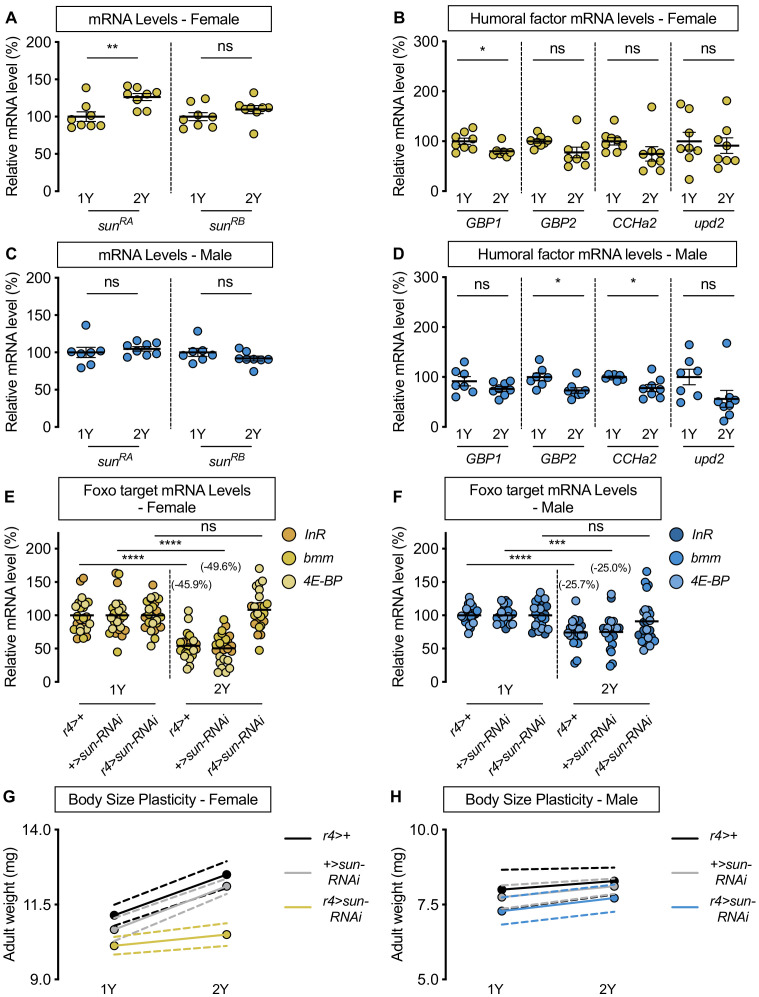
stunted is required for the nutrient-dependent upregulation of insulin pathway activity and increased female body size plasticity.(A) In females, mRNA levels of stunted (sun)RA, but not sunRB, were significantly higher in larvae cultured on a protein-rich diet (2Y) compared with larvae raised on a diet containing half the protein (1Y) (p=0.0055 and p=0.2327, respectively; Student’s t test). n = 8 biological replicates. (B) mRNA levels of Growth-blocking peptide 1 (Gbp1) were significantly different in females cultured on 2Y compared with females raised in 1Y (p=0.0245; Student’s t test); however, mRNA levels of Growth-blocking peptide 2 (Gbp2), CCHamide-2 (CCHa2), and unpaired 2 (upd2) were not significantly different between female larvae raised on 1Y and 2Y (p=0.0662, 0.1416, and 0.7171, respectively; Student’s t test). n = 7–8 biological replicates. (C) In males, mRNA levels of sunRA and sunRB were not significantly different in larvae raised on 2Y compared with larvae raised on 1Y (p=0.5832 and p=0.2017, respectively; Student’s t test). n = 7–8 biological replicates. (D) Levels of Gbp1 and upd2 were not significantly different between male larvae raised on 2Y compared with larvae reared on 1Y (p=0.1487, and p=0.1686, respectively; Student’s t test); whereas levels of Gbp2 and CCHa2 were significantly different between males raised in 2Y and 1Y (p=0.0214, and p=0.0272, respectively; Student’s t test). n = 7–8 biological replicates. (E) In control r4>+, and +>sun-RNAi females, mRNA levels of Foxo targets (insulin receptor (InR), brummer (bmm), and eukaryotic initiation factor 4E-binding protein (4E-BP)), were significantly lower in larvae cultured on 2Y compared with larvae raised on 1Y (p<0.0001, for both comparisons; Student’s t test). However, in r4>sun-RNAi females, there was no significant difference in Foxo target mRNA levels (p=0.2792; Student’s t test). n = 8 biological replicates. (F) In control r4>+, and +>sun-RNAi males, mRNA levels of Foxo targets were significantly lower in larvae cultured on 2Y compared with larvae raised on 1Y (p<0.0001 and p=0.0001, respectively; Student’s t test). While r4>sun-RNAi males showed no significant difference in Foxo target mRNA levels (p=0.2469; Student’s t test), there was no genotype:diet interaction among males (p=0.1068), suggesting that genotype had no impact on Foxo target genes. Importantly, there was a significant sex:diet interaction for Foxo target mRNA levels in both the r4>+ control (p=0.0166; two-way ANOVA followed by Tukey HSD test) and +>sun-RNAi control (p=0.0119; two-way ANOVA followed by Tukey HSD test), but not in r4>sun-RNAi larvae (p=0.1121; two-way ANOVA followed by Tukey HSD test). n = 7–8 biological replicates. (G) Adult weight was significantly higher in female flies raised in 2Y compared with females raised in 1Y in r4>+ and +>UAS-sun-RNAi controls (p<0.0001 for both genotypes; two-way ANOVA followed by Tukey HSD test); however, adult weight was not significantly different between r4>UAS-sun-RNAi females reared on 2Y compared with genotype-matched females raised on 1Y (p=0.5035; two-way ANOVA followed by Tukey HSD test). n = 7–10 groups of 10 flies. (H) Adult weight was not significantly higher in male flies reared in 2Y compared with males cultured in 1Y for r4>+ and +>UAS-sun-RNAi controls or r4>UAS-sun-RNAi males (p=0.8883, 0.6317, and 0.554, respectively; two-way ANOVA followed by Tukey HSD test). There was a significant sex:diet interaction in the r4>+ and +>UAS-sun-RNAi control genotypes (p=0.011 and p=0.0005, respectively; two-way ANOVA followed by Tukey HSD test), but no sex:diet interaction in the r4>UAS-sun-RNAi genotype (p=0.8749; two-way ANOVA followed by Tukey HSD test). n = 6–9 groups of 10 flies. For all body size plasticity graphs, filled circles indicate mean body size, and dashed lines indicate 95% confidence interval. * indicates p<0.05, ** indicates p<0.01, *** indicates p<0.001 **** indicates p<0.0001; ns indicates not significant; error bars indicate SEM.